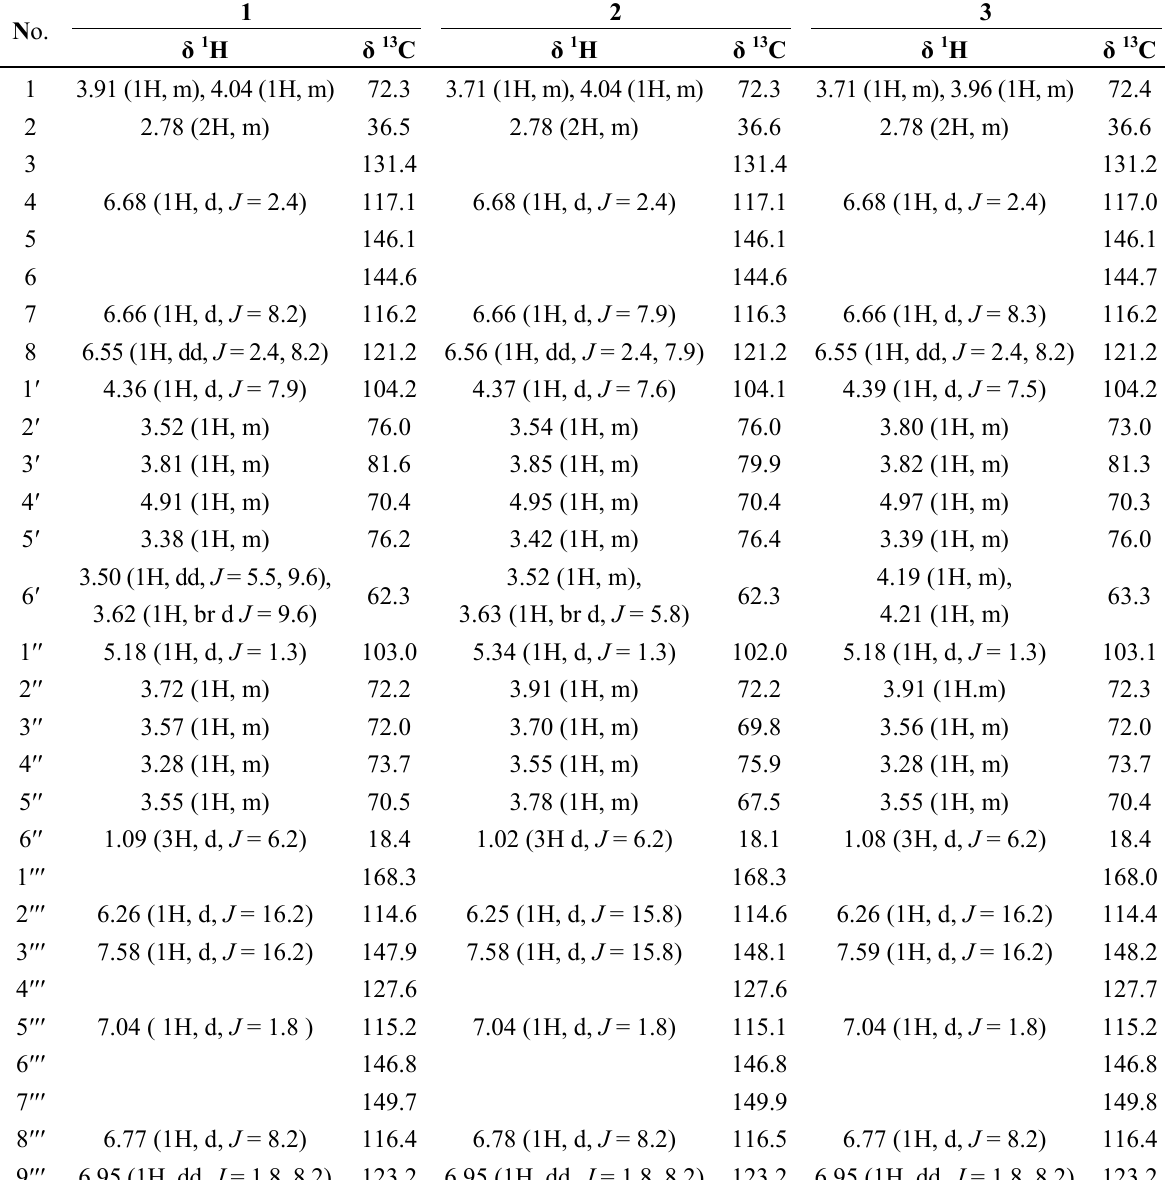
Table 1. 1 H-NMR and 13 C-NMR data for compound 1 – 3 (CD